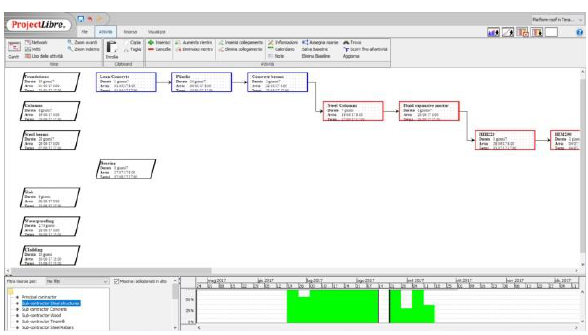
Figure 7. The Pert diagram in ProjectLibre